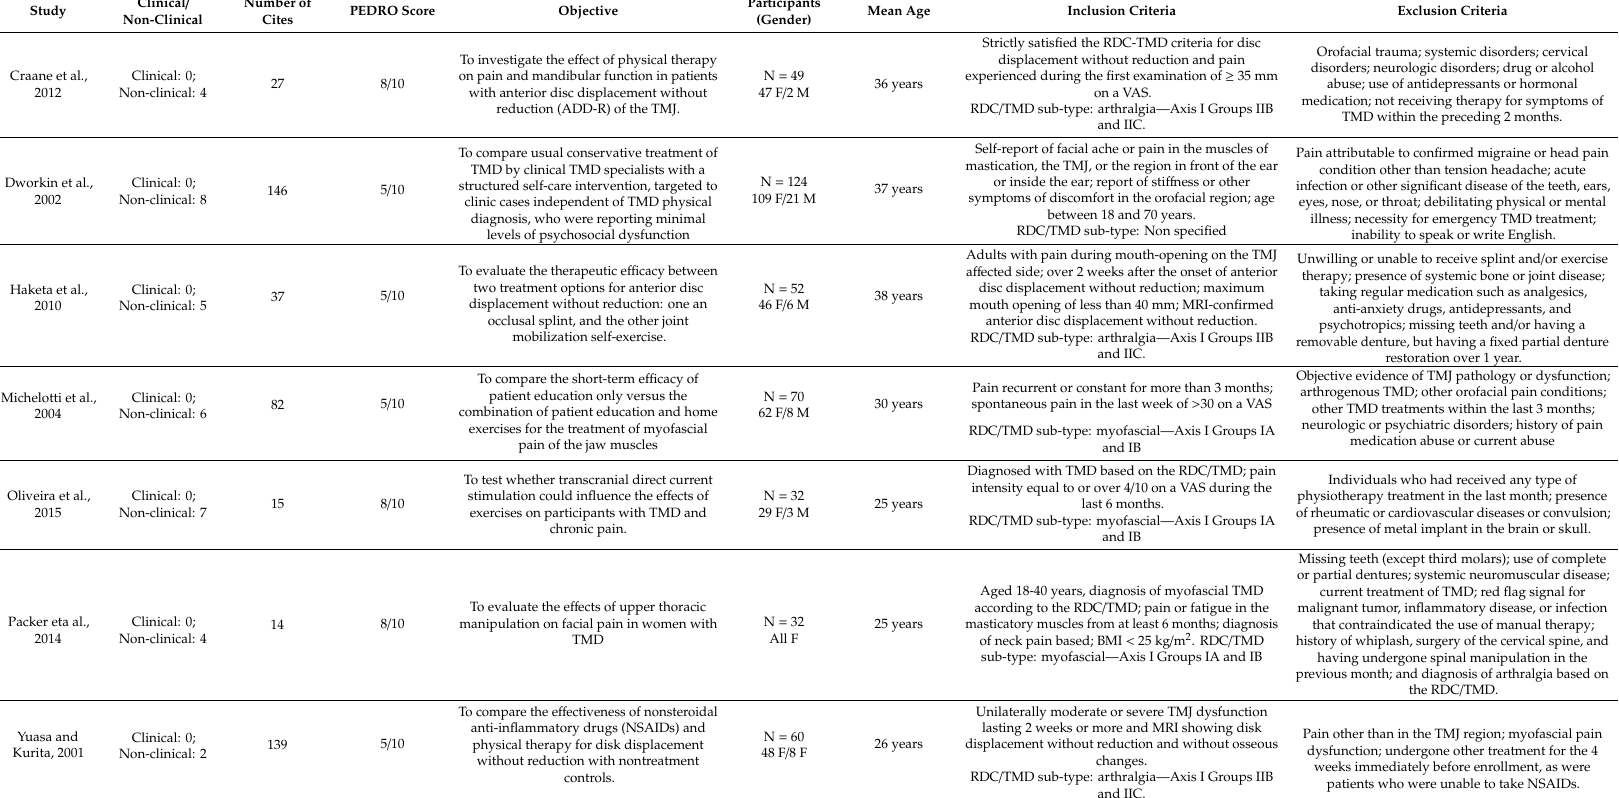
Table 3. Characteristics of clinical trials including patients with temporomandibular disorders fulfilling both citation and JCR criteria. F—Female; M—Male; TMD—Temporomandibular disorders; TMJ—Temporomandibular joint; RDC / TMD—Research Diagnostic Criteria for Temporomandibular disordes; VAS—Visual Analogue